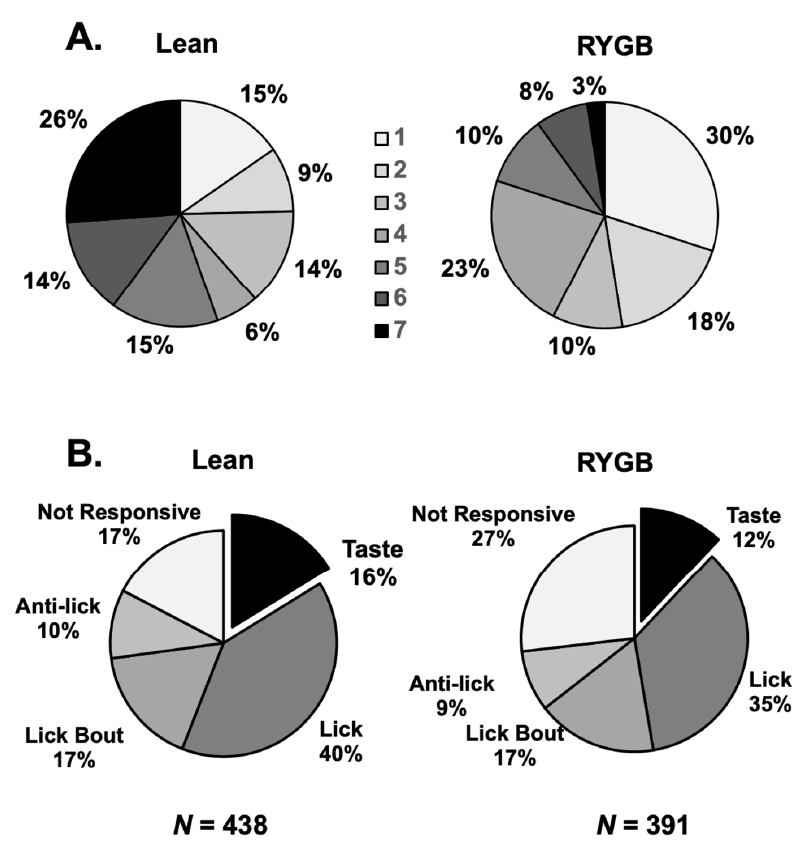
Figure 3. ( A ) Breadth of tuning of NTS taste-responsive cells in Lean (left) and RYGB (right) rats. Shown are the proportion of cells that respond to a single taste stimulus of the array versus two stimuli in the array, three stimuli, etc., up to the proportion of cells that responded to all seven taste stimuli. These distributions in Lean and RYG rats were statistically different (chi ‐ squared = 19.02, 6 df; p = 0.004). ( B ) Proportion of cells in the various categories of NTS cells in Lean (left) and RYGB (right) rats. The incidence of taste ‐ responsive cells in the NTS of each group of rats was comparable and the overall distributions were not statistically different (chi ‐ squared = 3.230, df = 4, p = 0.520). Table 1. Percent taste responses (number) in Lean and RYGB rats. Comparisons of taste-response measures showed that 5L responses were generally 5 ‐ Lick Lick ‐ by ‐ Lick similar in RYGB vs. Lean rats for any tastant, but LXL responses were weaker. For example, there were no differences in 5L response magnitudes evoked by individual tastants in RYGB vs. Lean rats (two-way ANOVA, F (1, 122) = 0.767, p = 0.383), as shown in Table 2. However, LXL responses were smaller in RYGB rats compared with those in Lean rats (two-way ANOVA, F (1, 280) = 19.17, p < 0.001). When all 5L responses were averaged, no differences in response magnitude between RYGB and Lean rats were apparent (see